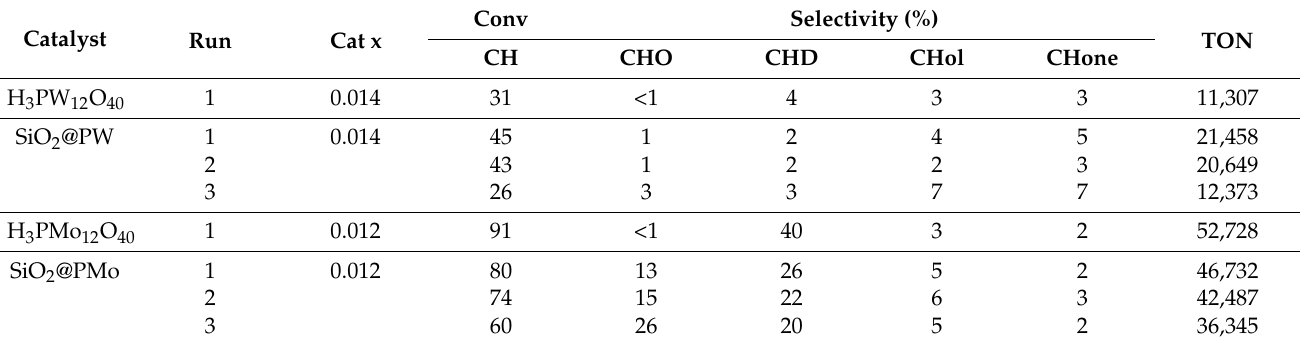
Table 14. CH epoxidation with heteropolyacids and corresponding anionic species from Figure 25. Analyzed species are in Figure 26.